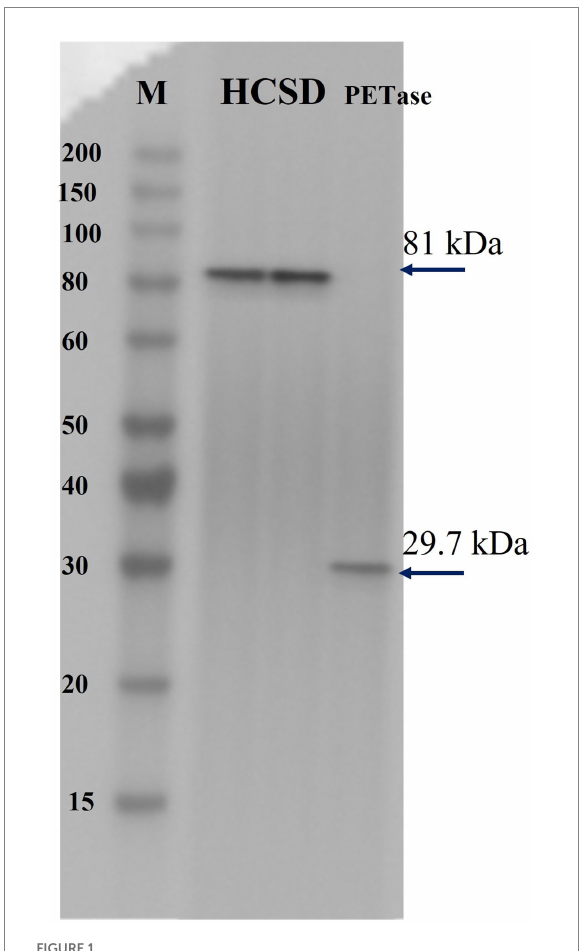
FIGURE 1 Immunoblotting of two HCSD proteins and PETase. Lane HCSD, Membrane protein extracts of E. coli BL21 (DE3) harboring pET- 30a (+): HCSD ; lane PETase, whole-cell lysates of E. coli BL21 (DE3) harboring pET-30a (+):